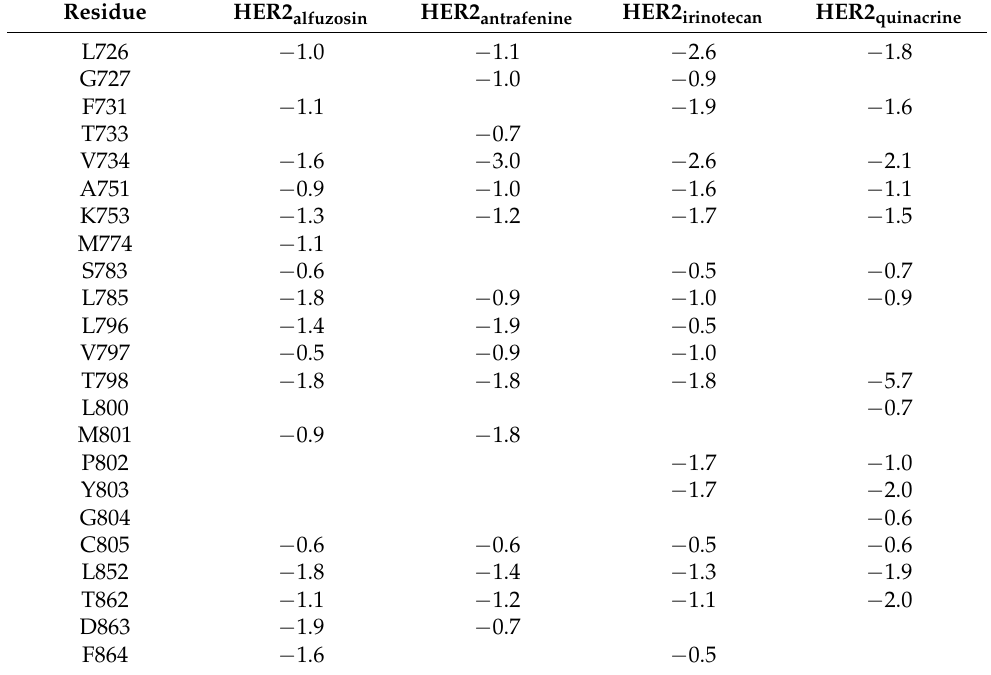
Table 4. Per-residue free energy for complexes formed between alfuzosin, antrafenine, irinotecan, and quinacrine with HER2 (values kcal/mol). Residue HER2 alfuzosin HER2 antrafenine HER2 irinotecan HER2 quinacrine